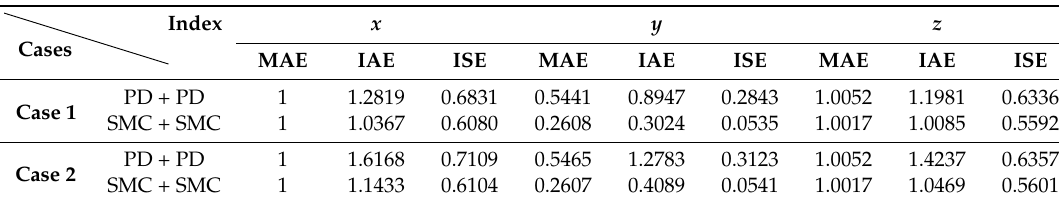
Table 4. Comparisons for two control schemes in two cases.